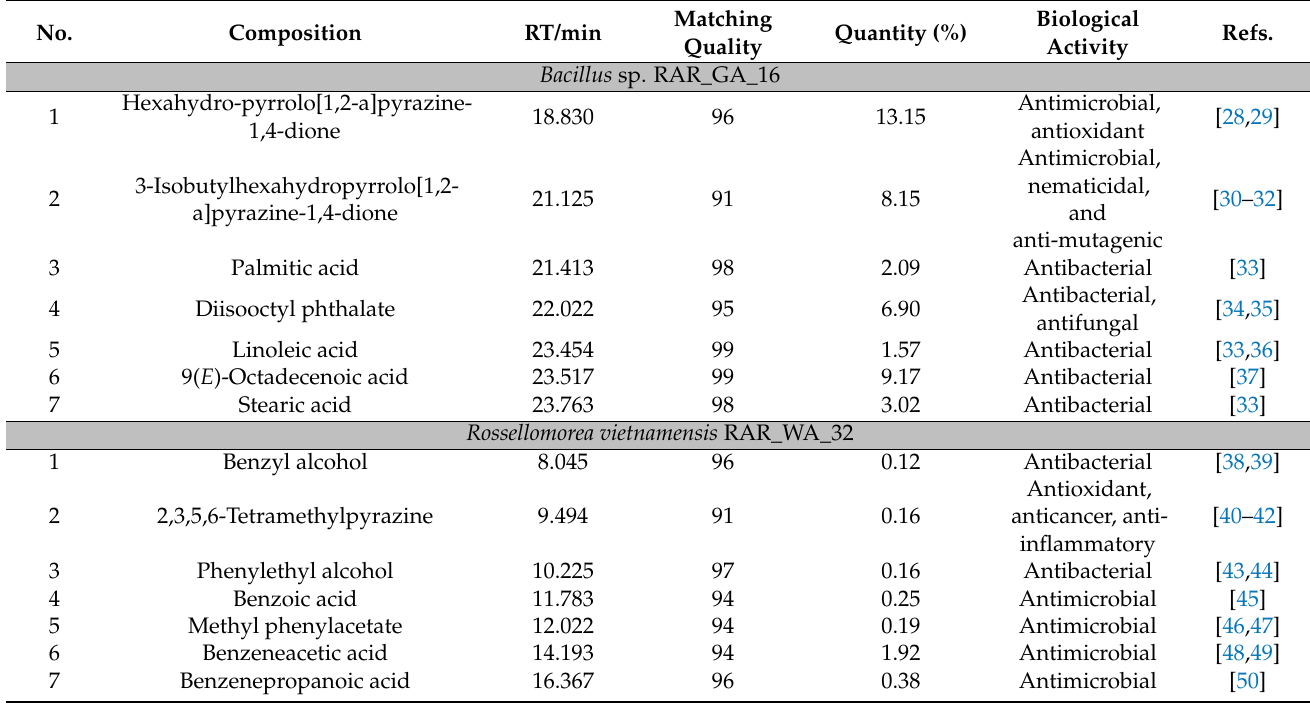
Table 6. The volatile chemical composition of the bacterial